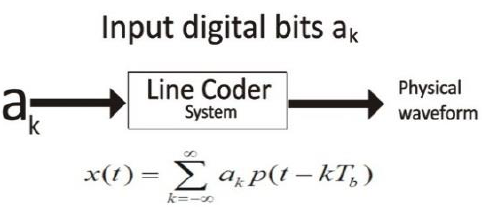
Figure 7. Line Coder System.